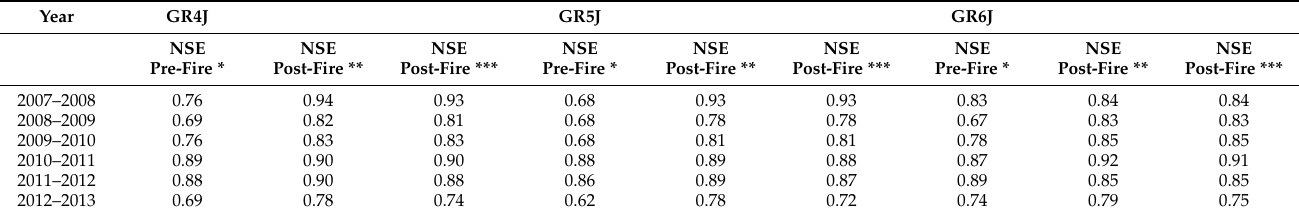
Table 4. Comparison of NSE values for pre-fire and post-fire period using the GR